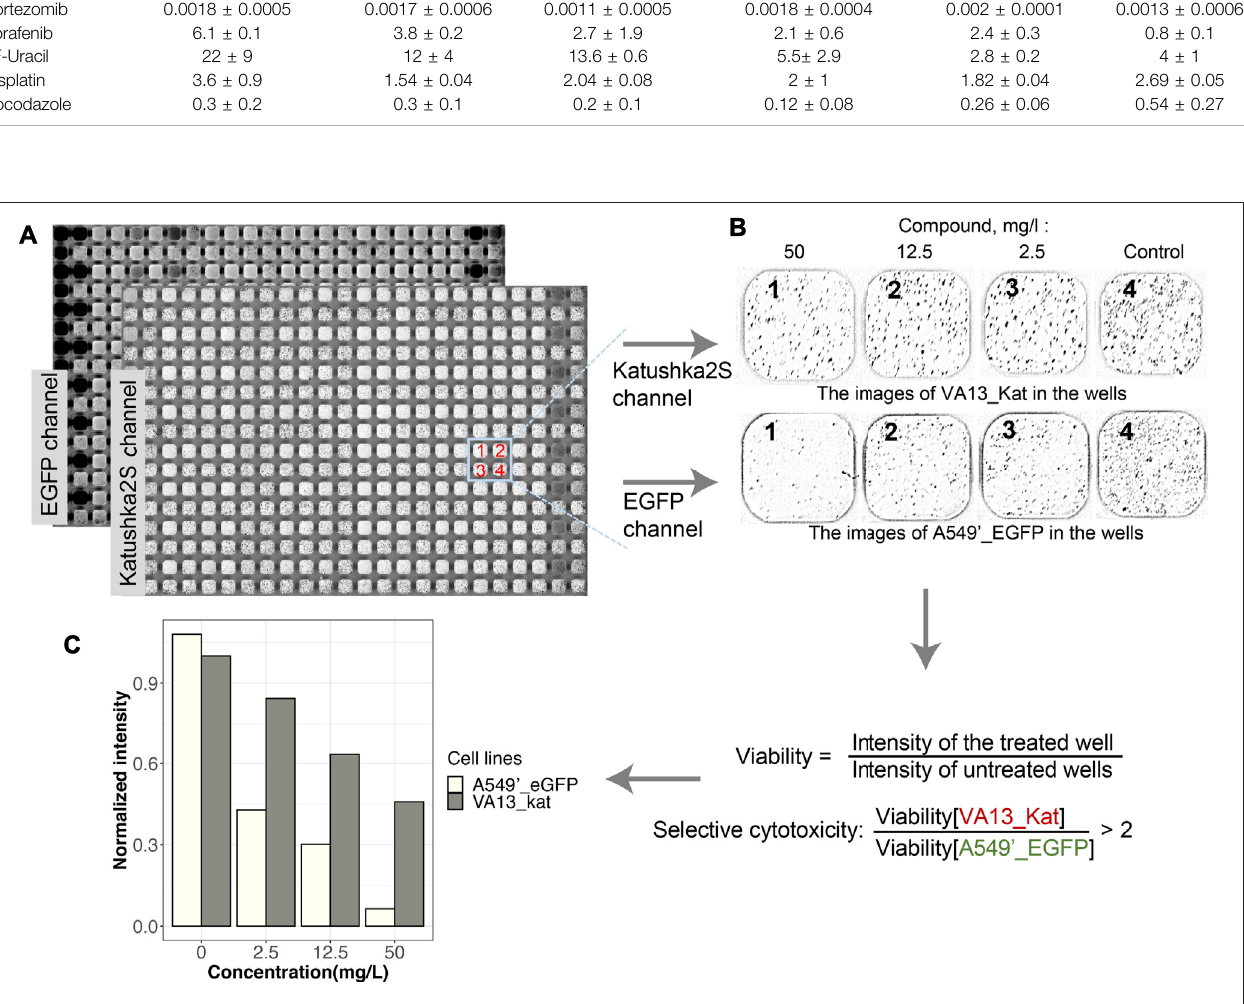
FIGURE 2 | Scheme of analysis of the viability of the cells in mixed culture for the screening of compounds. (A) . Scanned images of the plate with cells obtained in the green and far-red channels of fl uorescence. The mapped out section of the plate corresponds to three dilutions of one drug (wells 1 – 3) and a well without a drug (4). Dark pixels in the wells correspond to cells. Light wells without dark pixels in the image indicate the death of the cells after treatment. Uniformly, dark cells on the image correspondtohighbackgroundlevelsfrom fl uorescentdrugs. (B) .ImagesofcellsinthesamewellsinEGFPandKatushka2Schannelsareshownaftersubtraction of the pseudo-background and image fragmentation for viability calculation. (C) . An example of the viabilities of cells after treatment with bexarotene and processing of image are given (for details see Methods and Supplementary Figure S4 ); the selectivity index of cytotoxicity is determined by the ratio of viable VA13_Kat cells to A549 ’